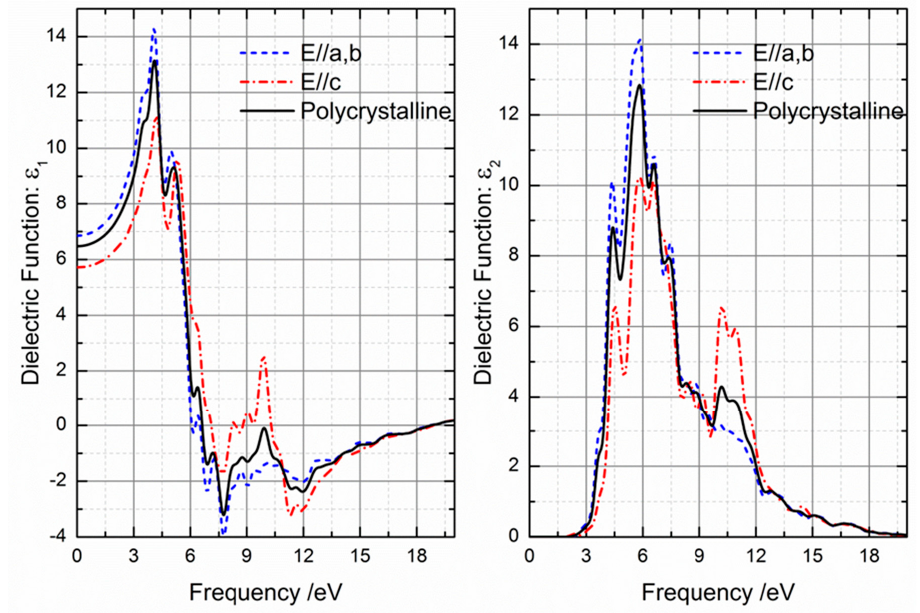
Figure 7. Imaginary and real parts of the dielectric functions of BiOI along two polarization directions and for the polycrystalline model calculated by the HSE06 method.